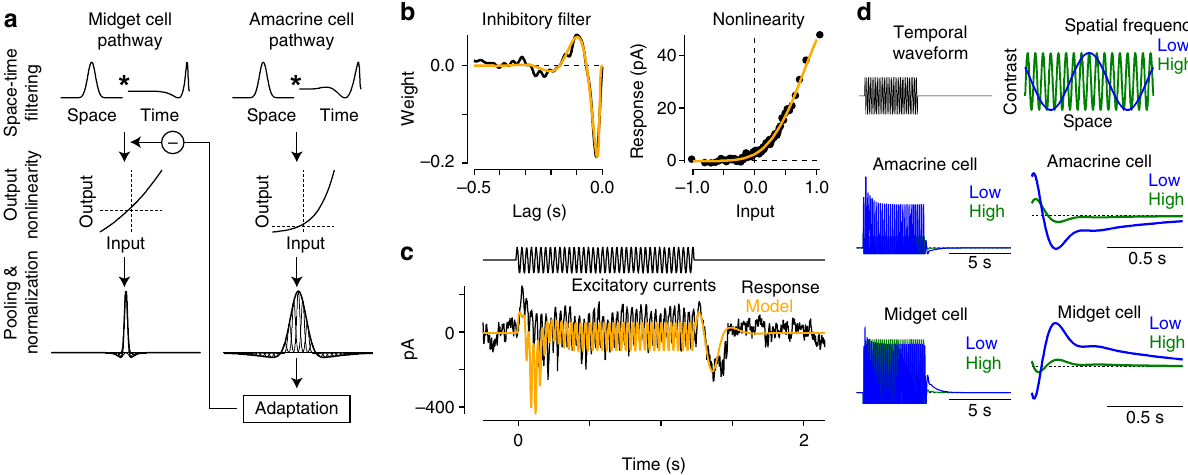
Fig. 8 Sensitization model reproduces experimental results. a Sensitization model structure. Visual inputs were convolved with a spatiotemporal linear fi lter comprised of a Gaussian in space and a biphasic fi lter in time. Signals in the amacrine cell pathway were then passed through an output nonlinearity before passing to the adaptation stage of the model. The output of the amacrine cell model provided inhibitory input to the midget bipolar cell pathway upstream of the bipolar cell output nonlinearity. b Inhibitory temporal fi lter (left) and input – output nonlinearity (right) determined from noise recordings. These fi lters were then used as components of the computational model ( a ). c Excitatory current recording from an Off midget ganglion cell to the wide- fi eld adapting stimulus (see Fig. 7). Model prediction (orange) was generated from excitatory synaptic current recordings to the noise stimulus in the same cell. d